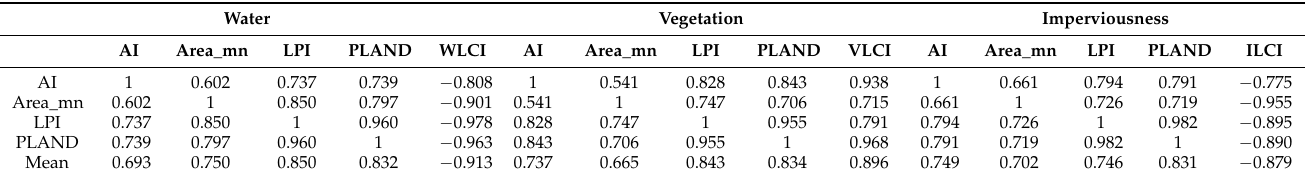
Table 6. Correlation matrix of three comprehensive indexes and landscape pattern index.